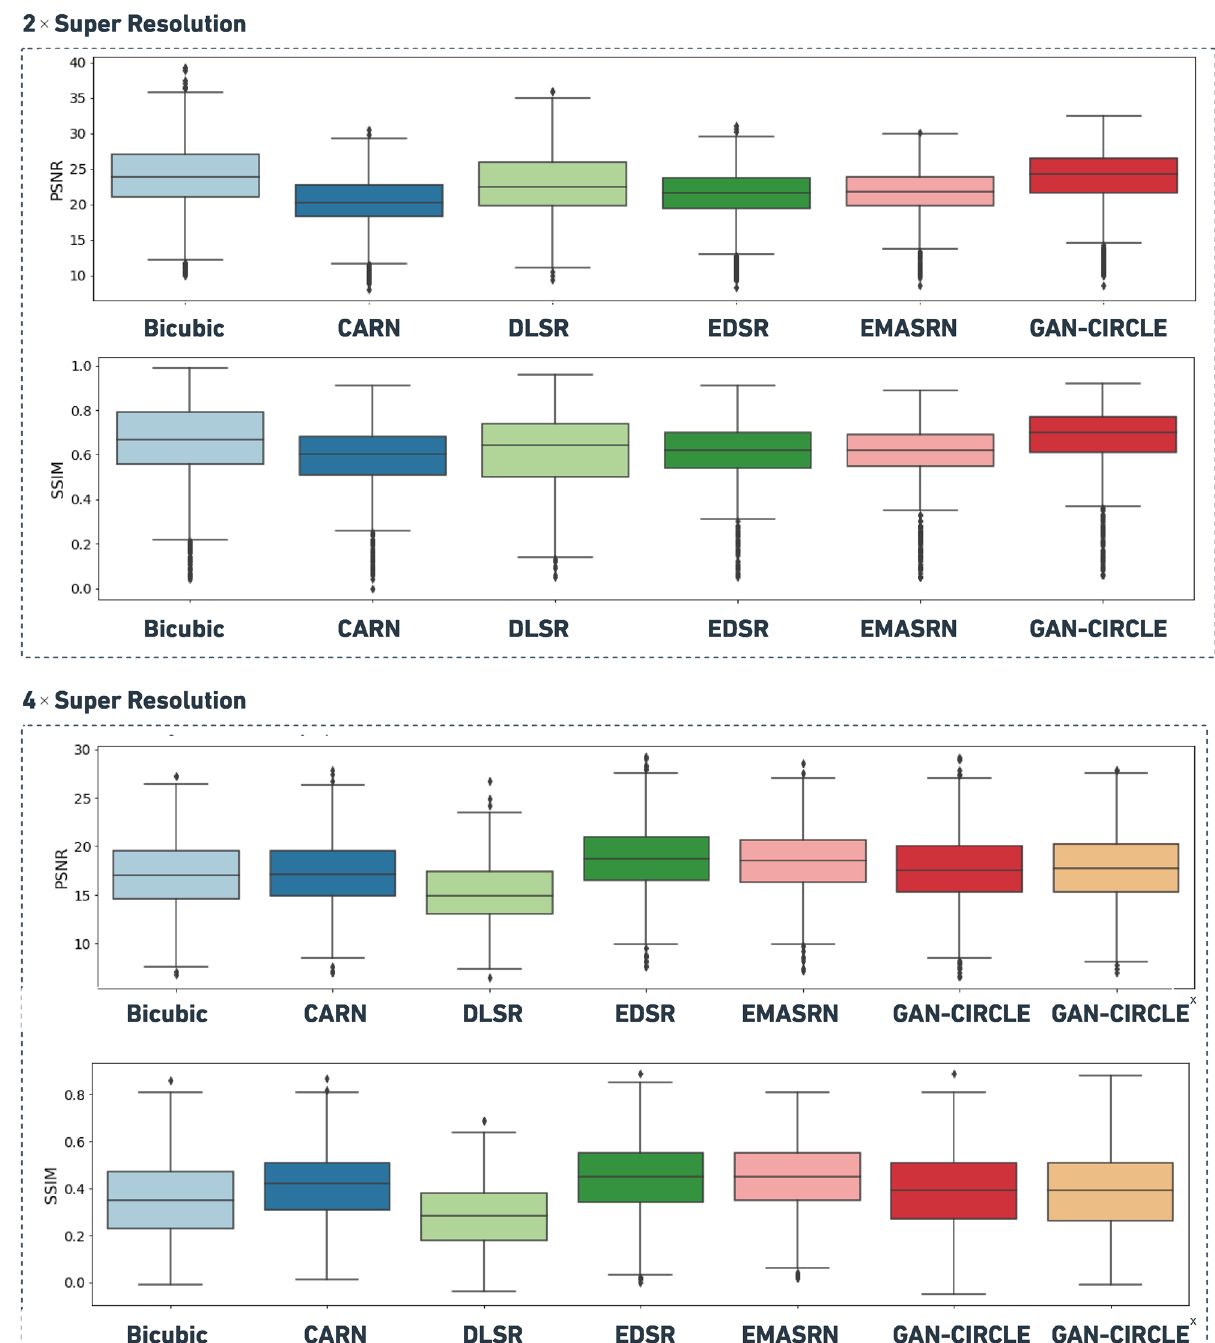
Figure 4. Boxplots comparing PSNR and SSIM metrics for 1000 CT images held out for performance evaluation, super-resolved at 2 × and 4 × by using the investigated SR methods. In the case of 4 × SR, GAN- CIRCLE x denotes the sequential application of two GAN-CIRCLE instances at 2 ×